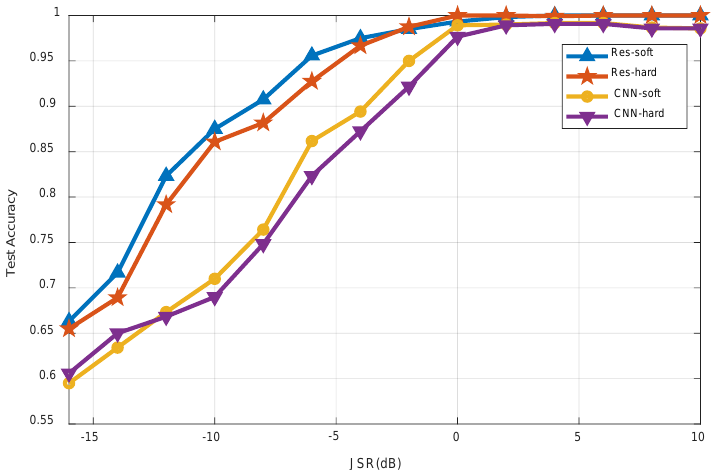
Experiment 4: Performance comparison of the of hard-fusion based and soft-fusion based multi-node cooperative jamming recognition. Figure 11 gives the performance curves of the residual network as well as the existing CNN for the soft-fusion based method and the hard-fusion based method when the number of co-cognitive nodes is six. Looking at Figure 11, it can be observed that the residual network outperforms the CNN method in both fusion methods, and the soft-fusion based method outperforms the hard-fusion based method overall. This is because the residual connections incorporated in the residual network allow for better gradient and training information transfer in the deeper network, resulting in better performance of the trained network. Compared to the hard-fusion based method, the soft-fusion based method fuses more information and takes more advantage of multi-node jamming perception. However, the soft-fusion based method also results in increased transmission information, placing higher demands on the data processing capabilities of the central node and adding additional system complexity.